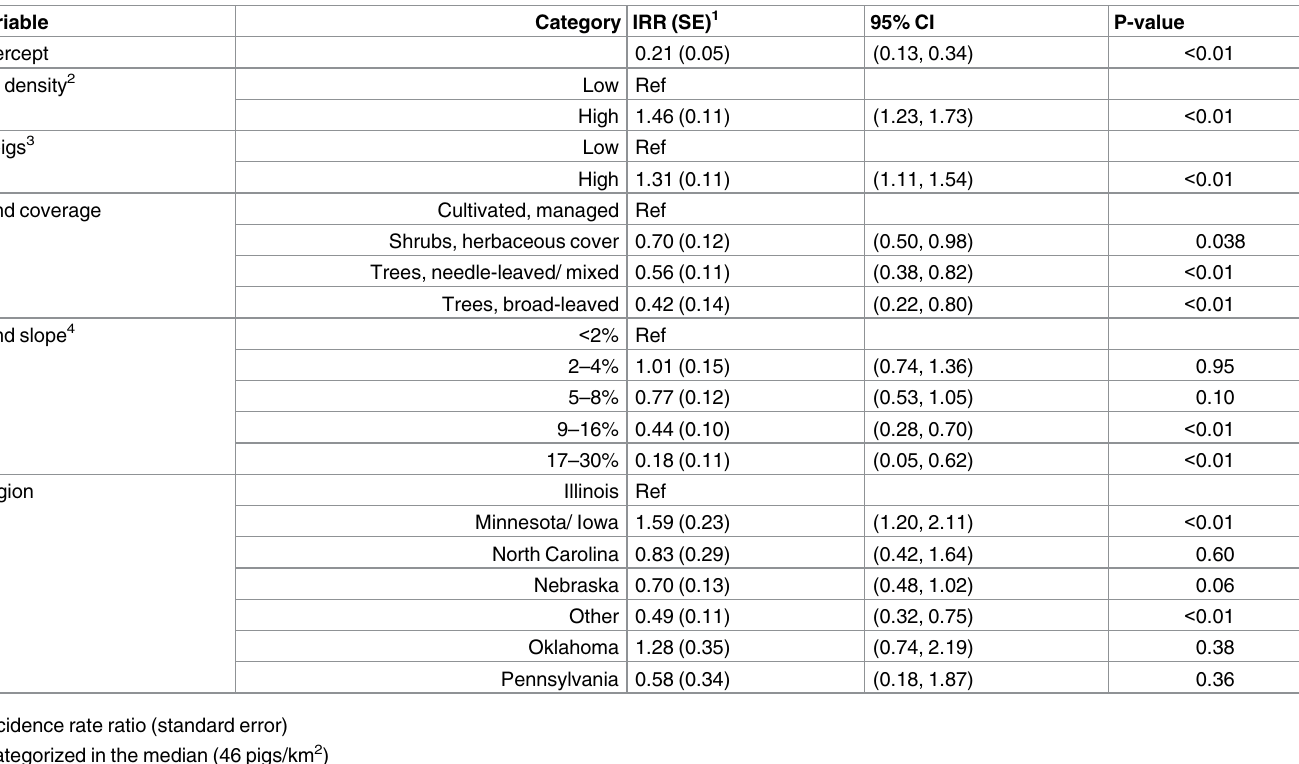
Table 2. Final multivariable generalized mixed Poisson model; the main outcome modeled herein was the counts of PRRS outbreaks using 706 sow sites as the unit of analysis, and an offset to account for different numbers of yearsparticipating in data collection (2009–2016) was used. The model accountedfor clusteringof swine sites within production systems using a